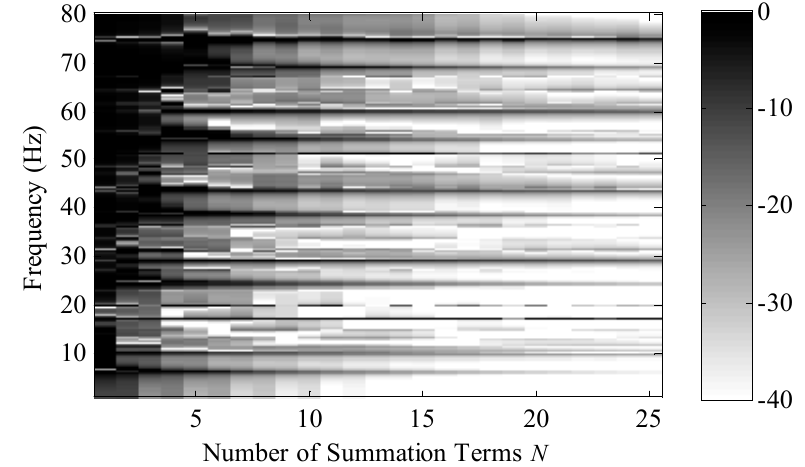
Figure 6. Convergence of the longitudinal displacement versus total number of summation terms and frequency for rod with triangular change of area expressed in a decibel scale.